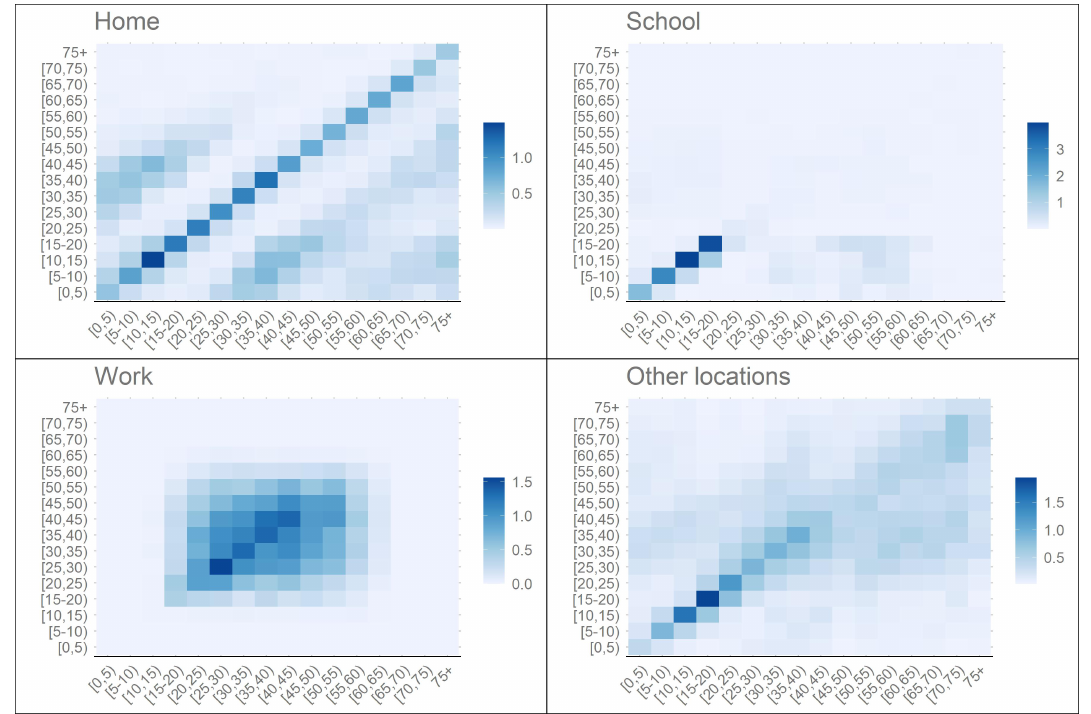
Figure 2. Portuguese synthetic contact patterns for school, home, work and other locations prior to the pandemic